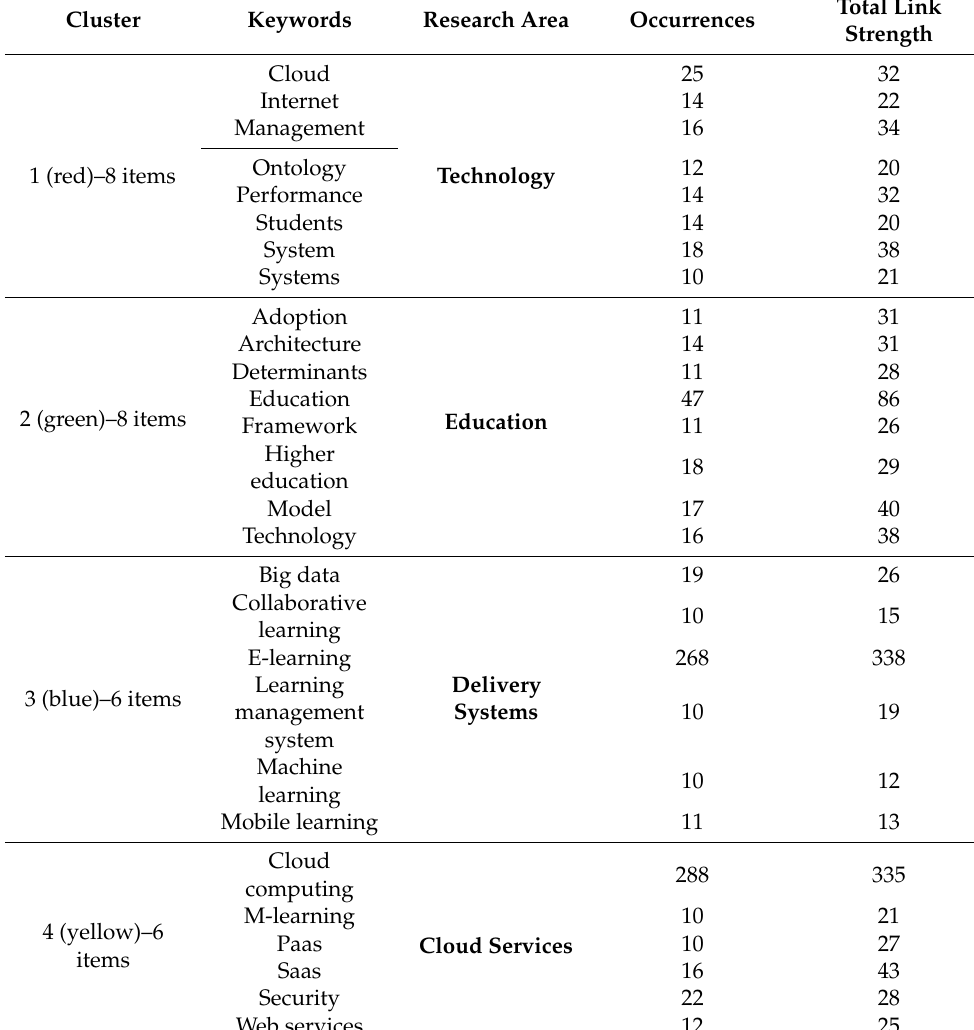
Table 7. Author keyword